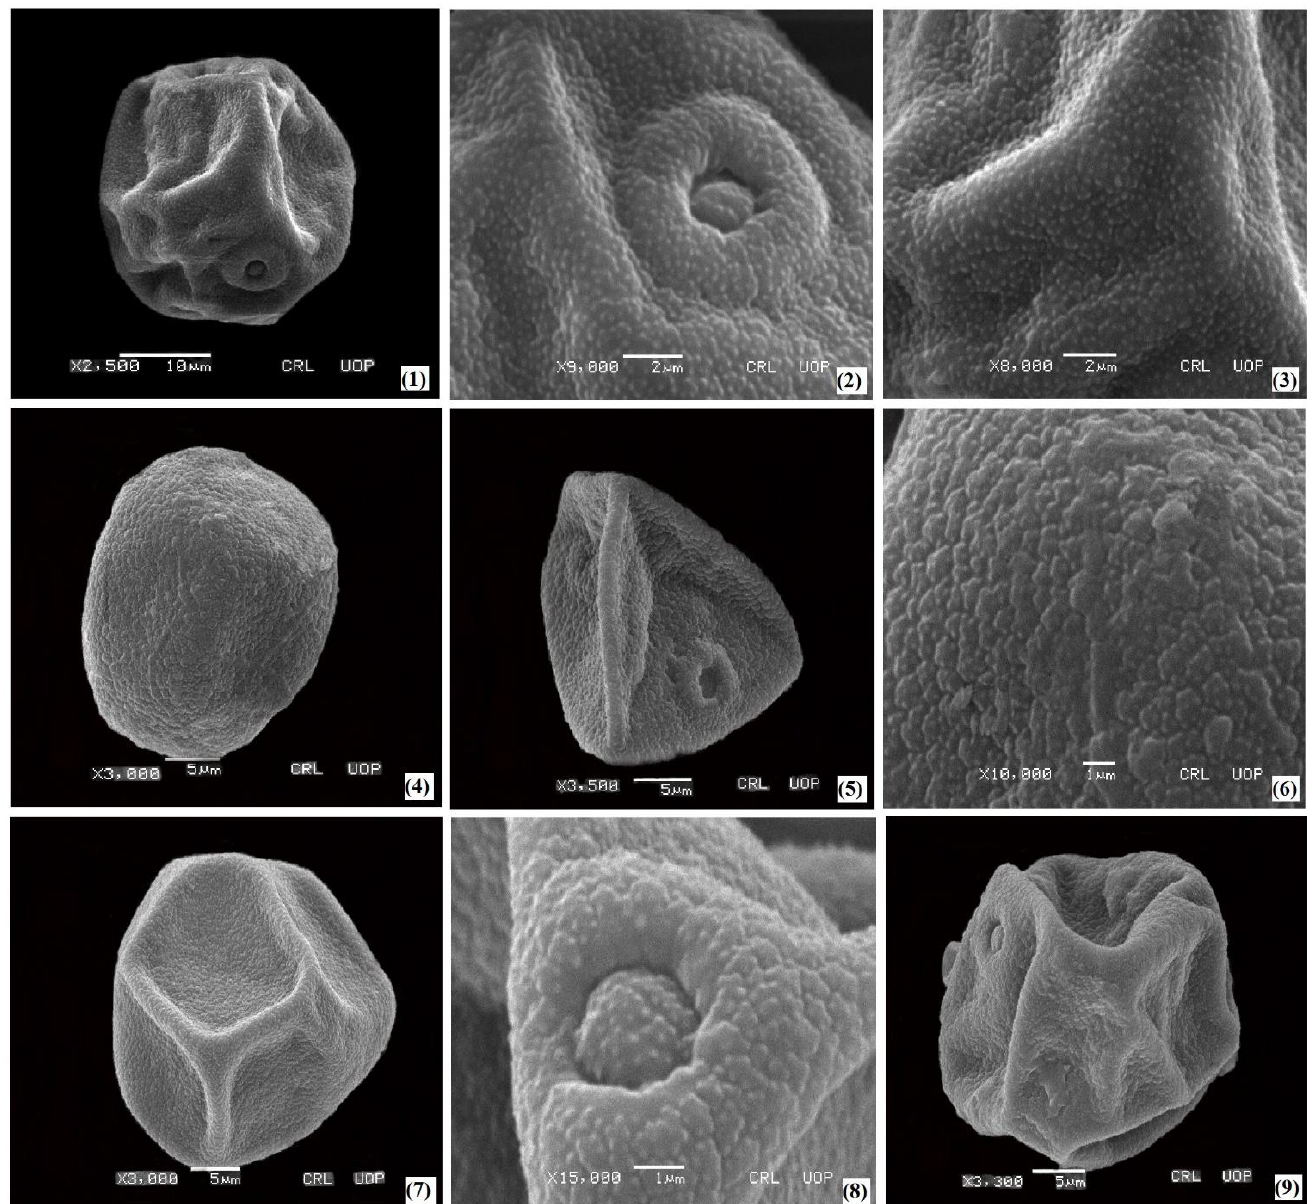
Figure 2. SEM pollen micrographs of salt tolerant grasses. Urochloa ramosa (1, 2 & 3), Calamagrostis pseudophragmites (4, 5 & 6), Cenchrus biflorus (7, 8 & 9).